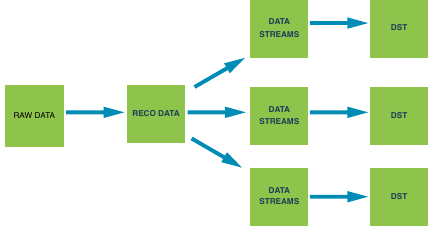
Figure 1. Typical process for production of end-user analysis data.